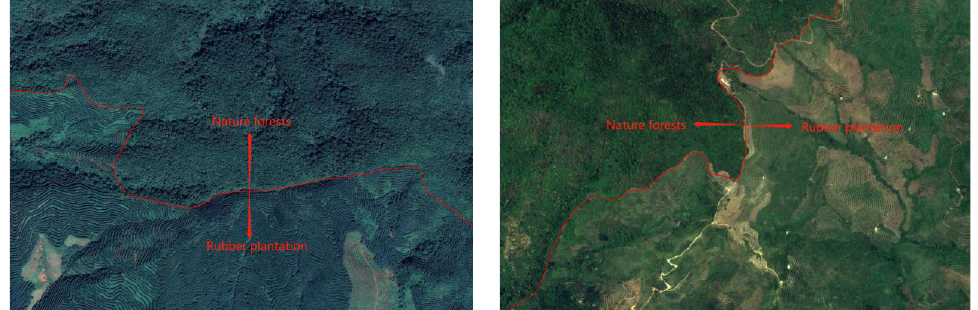
Figure 7. Natural forests and rubber plantation areas around Wild Elephant Valley. The high-resolution images showed the clear boundary between natural forest and rubber